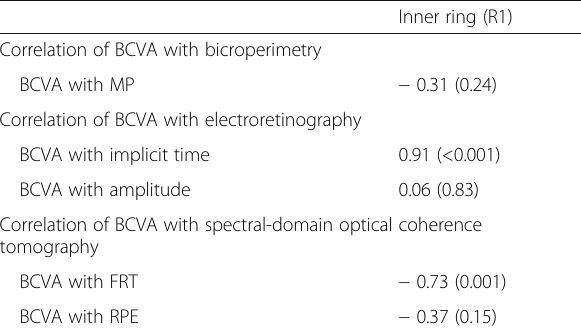
BCVA with FRT − 0.73 (0.001) BCVA with RPE − 0.37